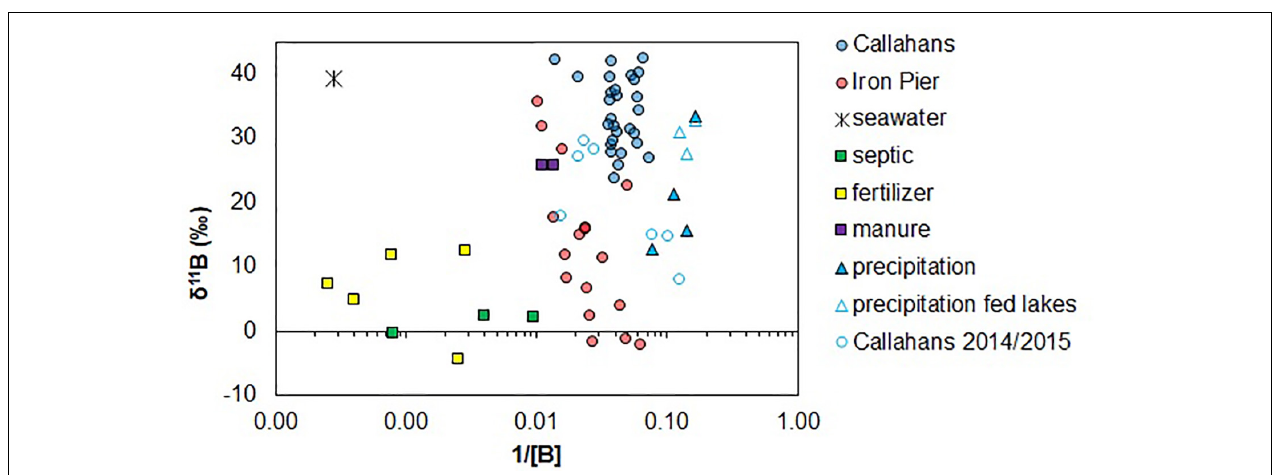
FIGURE 5 | Log of 1/B vs. δ 11 B of coastal groundwater samples and different endmembers analyzed in this study.